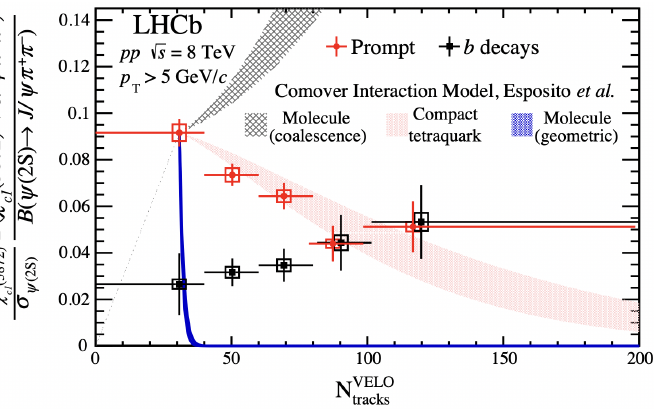
Figure 20. The ratio of χ c 1 (3872) to ψ (2S) from prompt (red squares) and b decays (black squares) as a function of charged tracks in p + p collisions [90]. The data are compared with different theoretical models described in the text. Reprinted with permission from American Physical